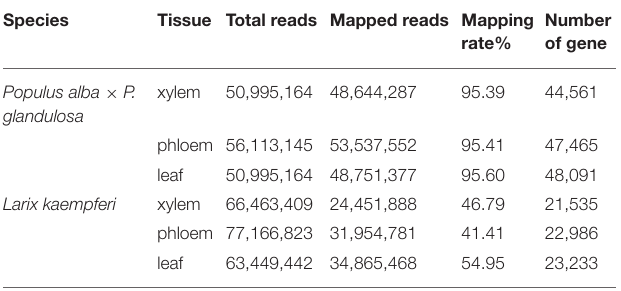
TABLE 1 | Summary information of the RNA-Seq results for the two tree species. Species Tissue Total reads Mapped reads Mapping